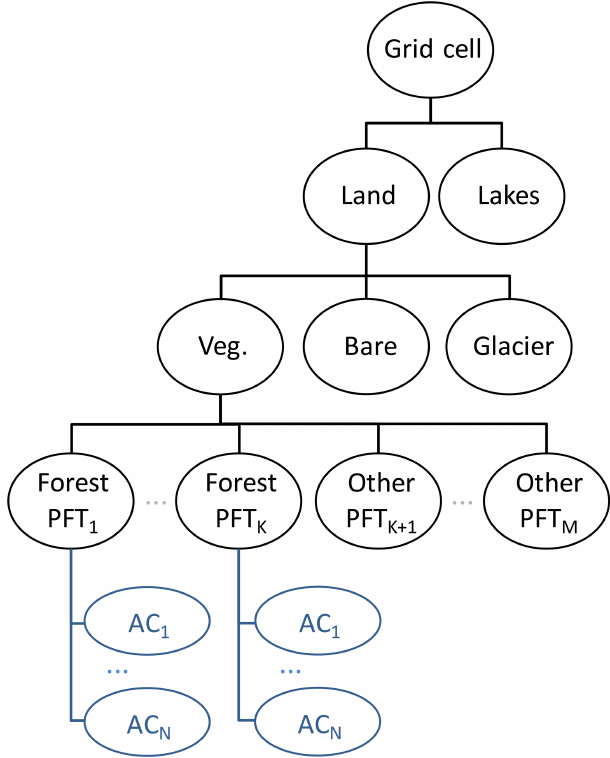
Figure 1. The hierarchical tile structure of JSBACH4. In our study, the default tile structure of JSBACH4 (in black) has been extended by a variable number N of forest age classes (ACs) below each of the K forest plant functional types (PFTs; in